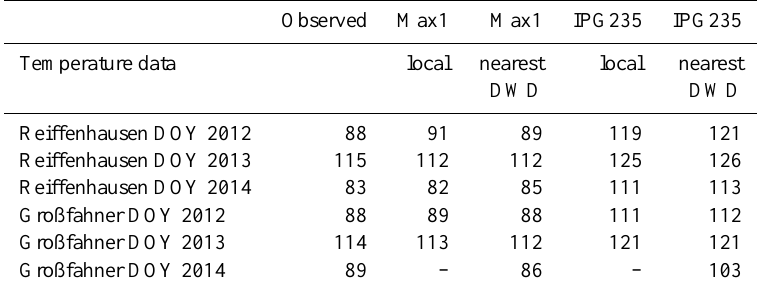
Table 2. Observed and estimated day of years (DOY) of leaf unfolding (LU) for Reiffenhausen and Großfahner. The Max1 parameters are calibrated at the observations in Reiffenhausen using local temperatures (2012 and 2013) and evaluated with Reiffenhausen (2014) and Großfahner (2012–2014). Additionally the DOY of LU is compared to estimates using the IPG235 parameter set as well as the temperatures of the nearest DWD climate station (Göttingen for Reiffenhausen, distance approx. 17km; Dachwig for Großfahner, distance approx. 3.5km) are